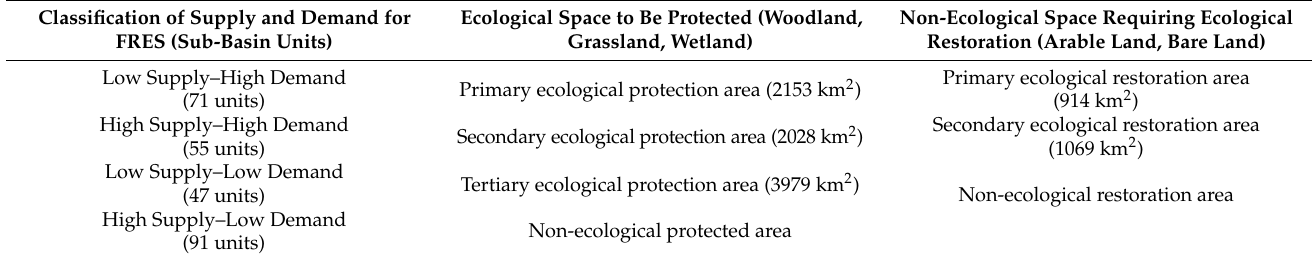
Figure 14. Comparison of FRES supply and demand at the sub-basin level in Fujian Delta. Table 4. Ecological spatial regionalization of the Fujian Delta based on a comparison of FRES supply and demand in the